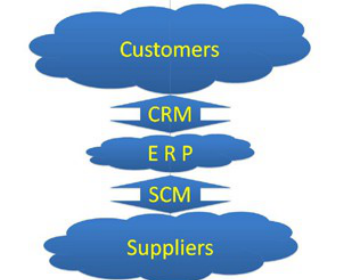
Figure 2. Relationship among CRM, ERP and